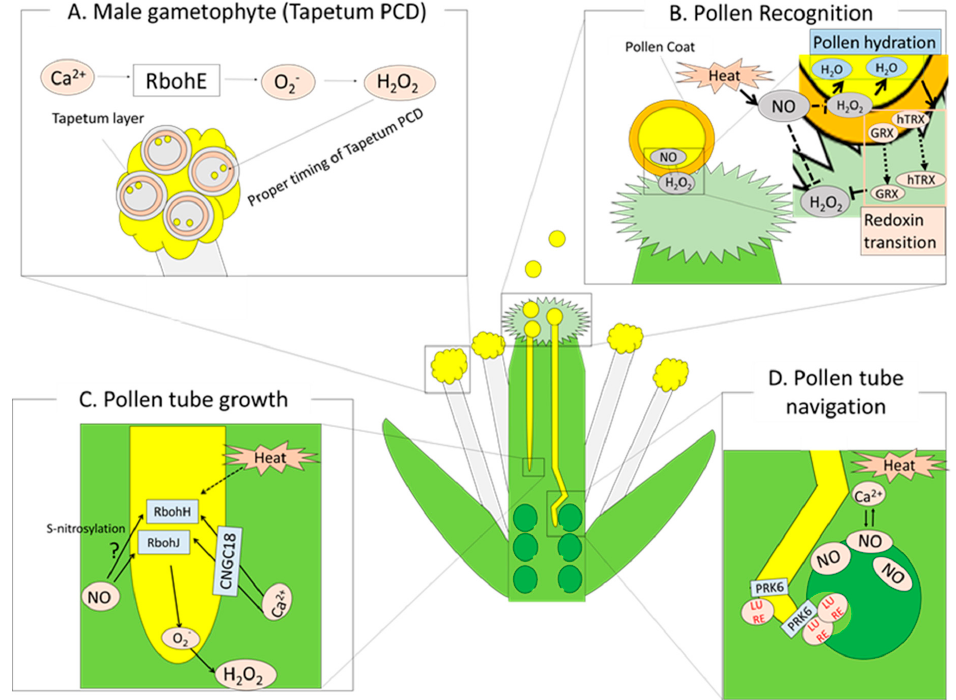
Figure 4. Integration between ROS, NO, and Ca 2+ signals in reproductive tissues that can be affected by heat stress. The models indicate the signals that function in different reproductive developmental processes. ( A ) Tapetum programmed cell death (PCD) occurs in anthers. Respiratory burst oxidase homolog E (RbohE) regulated by Ca 2+ is essential to generate ROS that accelerate PCD. ( B ) Pollen–pistil interaction occurs on stigma. Redoxin proteins such as H-type thioredoxins (hTRXs) and glutaredoxins (GRXs), which accumulate in pollen grains and pollen coats, are rapidly released to papilla cells on the top of stigma. ( C ) Pollen tube elongation inside style. ROS produced by respiratory burst oxidase homologs H and J (RbohH and J) in the tip of pollen tubes might be key regulators of this process, ( D ) Pollen tube navigation toward ovules. NO in ovules modulated by Ca 2+ signals might function as a negative chemotraffic substance for pollen tube navigation to prevent inappropriate guidance. LURE and pollen receptor-like protein kinase 6 (PRK6) function to properly guide pollen tube elongation. Green and yellow colors indicate female and male reproductive tissues, respectively; small yellow particles in ( A ) indicate pollens; the dotted arrows in ( B ) indicates transfer of molecules; the green circle in ( D ) indicates ovule. Black arrows indicate positive regulation; T-shaped lines indicate negative regulation. The pathways that can be hypothesized but not clearly evidenced in previous studies are marked with “?”.